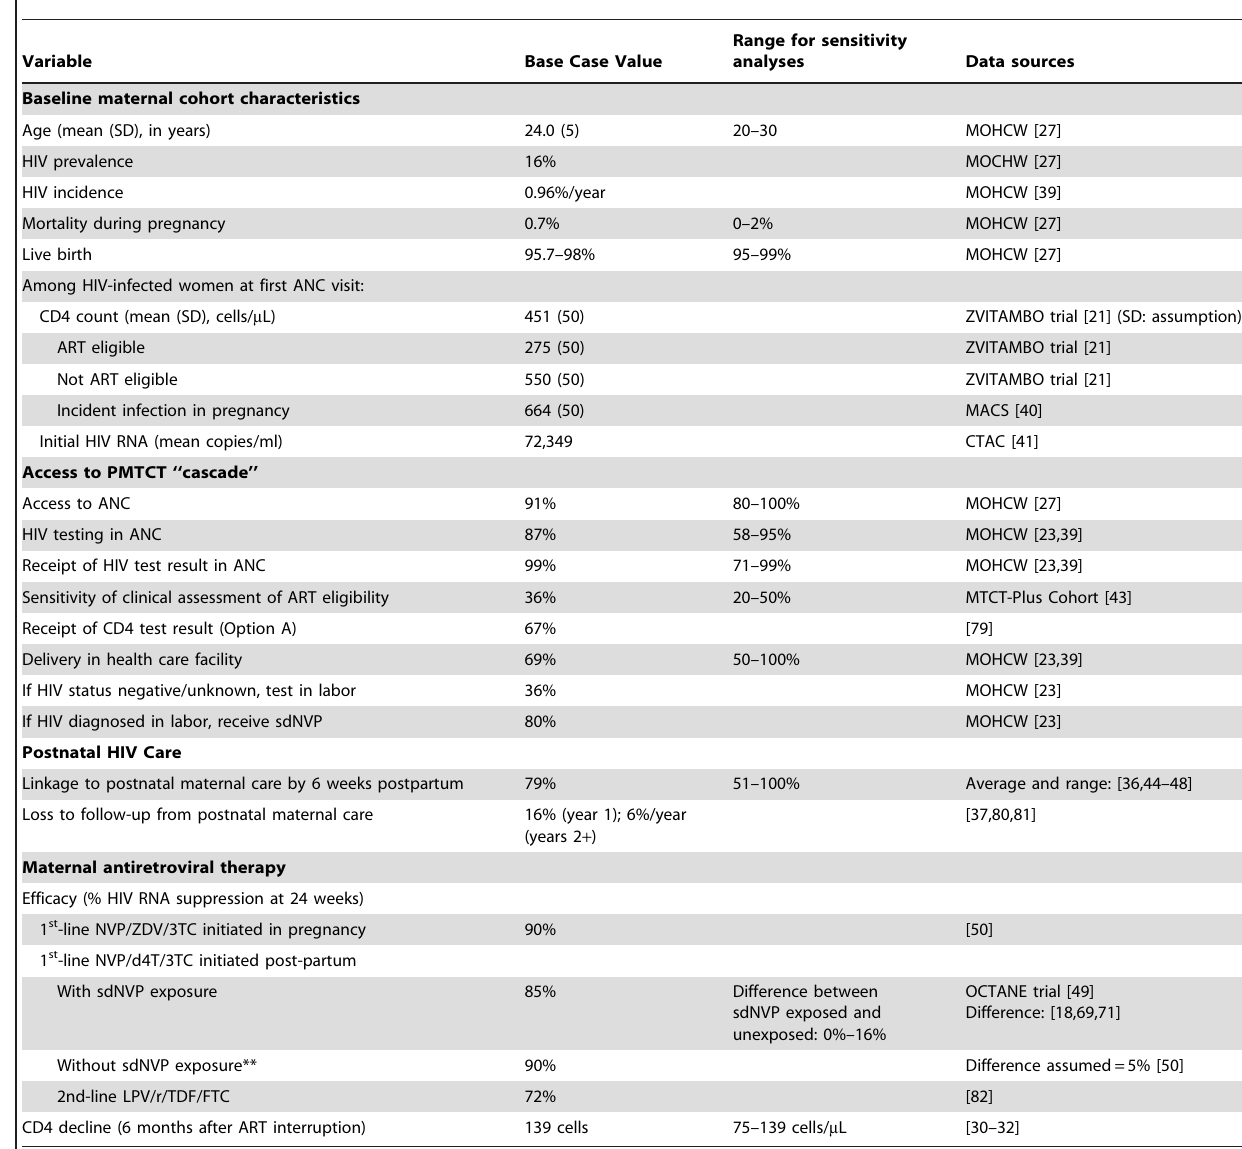
Table 1. Selected model input parameters for a simulation model of strategies to prevent mother-to-child transmission of HIV in Zimbabwe: Maternal